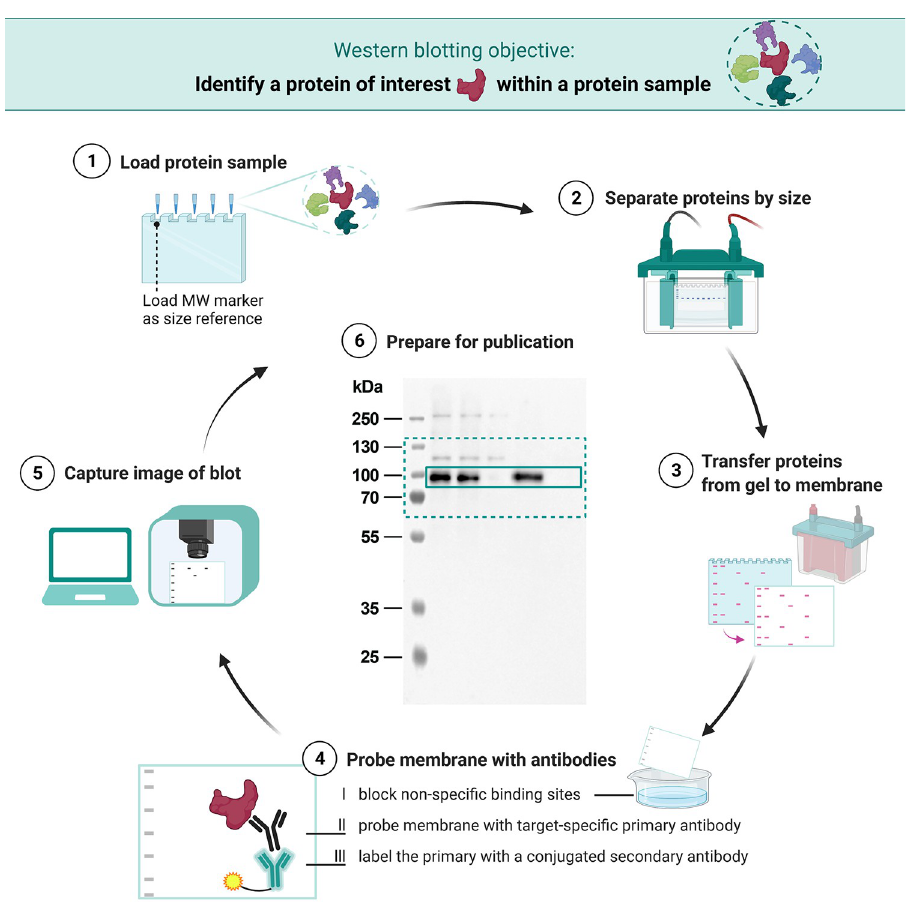
Fig 1. Western blot: From gel to publication. Western blotting is a standard laboratory method that uses antibodies to detect target proteins in a sample. (1) The sample, typically a mixture of proteins, is loaded on the gel. A molecular weight (MW) marker, which contains prelabeled proteins of varied, known molecular weights, is loaded on the gel alongside the protein sample as a size reference. (2) Gel electrophoresis is used to separate proteins based on their molecular weight. (3) The proteins are transferred, or “blotted”, onto a membrane. (4) The membrane is blocked to reduce nonspecific binding and then sequentially probed with a primary antibody that specifically binds to the protein of interest and a secondary antibody. The latter binds the primary antibody and carries an enzyme or a fluorophore that allows subsequent detection. (5) The signal is detected through a chemiluminescent reaction or fluorescence, respectively. (6) An image of the western blot is prepared for publication: Annotations are added and often the blot is cropped. For the unprocessed image, see S1 Fig.